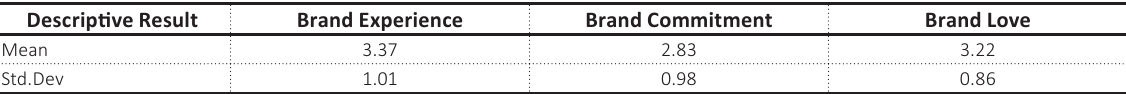
Table 3. Descriptive statistics for each variable Descriptive Result Brand Experience Brand Commitment Brand Love